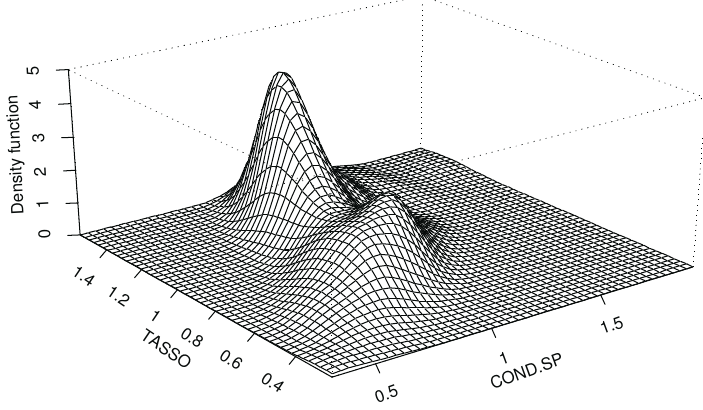
Figura 6 – Evoluzione da non condizionata a condizionata agli spillover di prossimità .